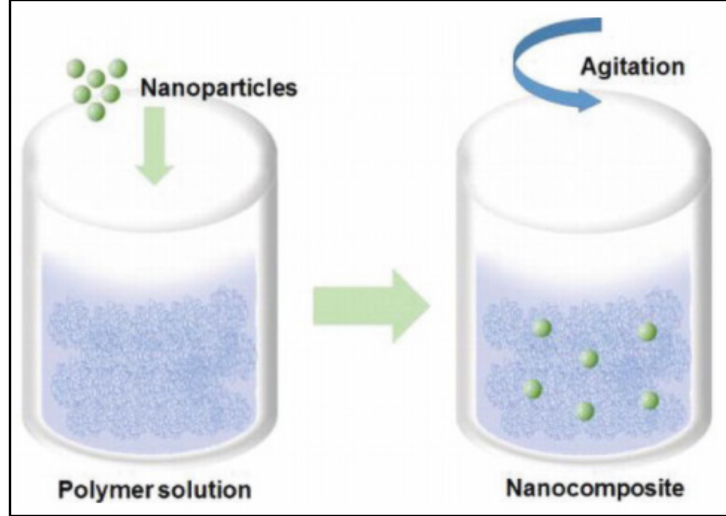
Figure 5. Polymer nanocomposite by solvent method